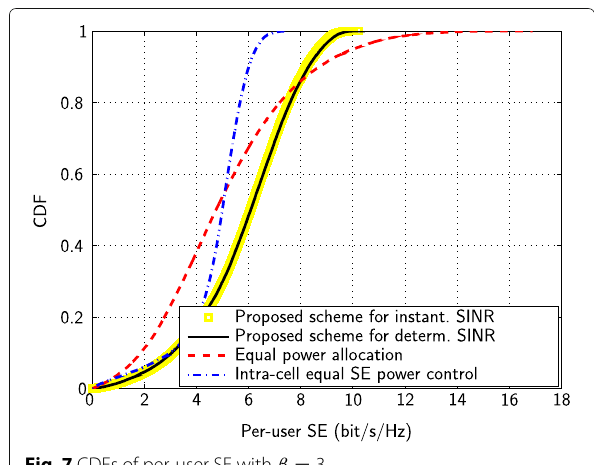
Fig. 7 CDFs of per-user SE with β =